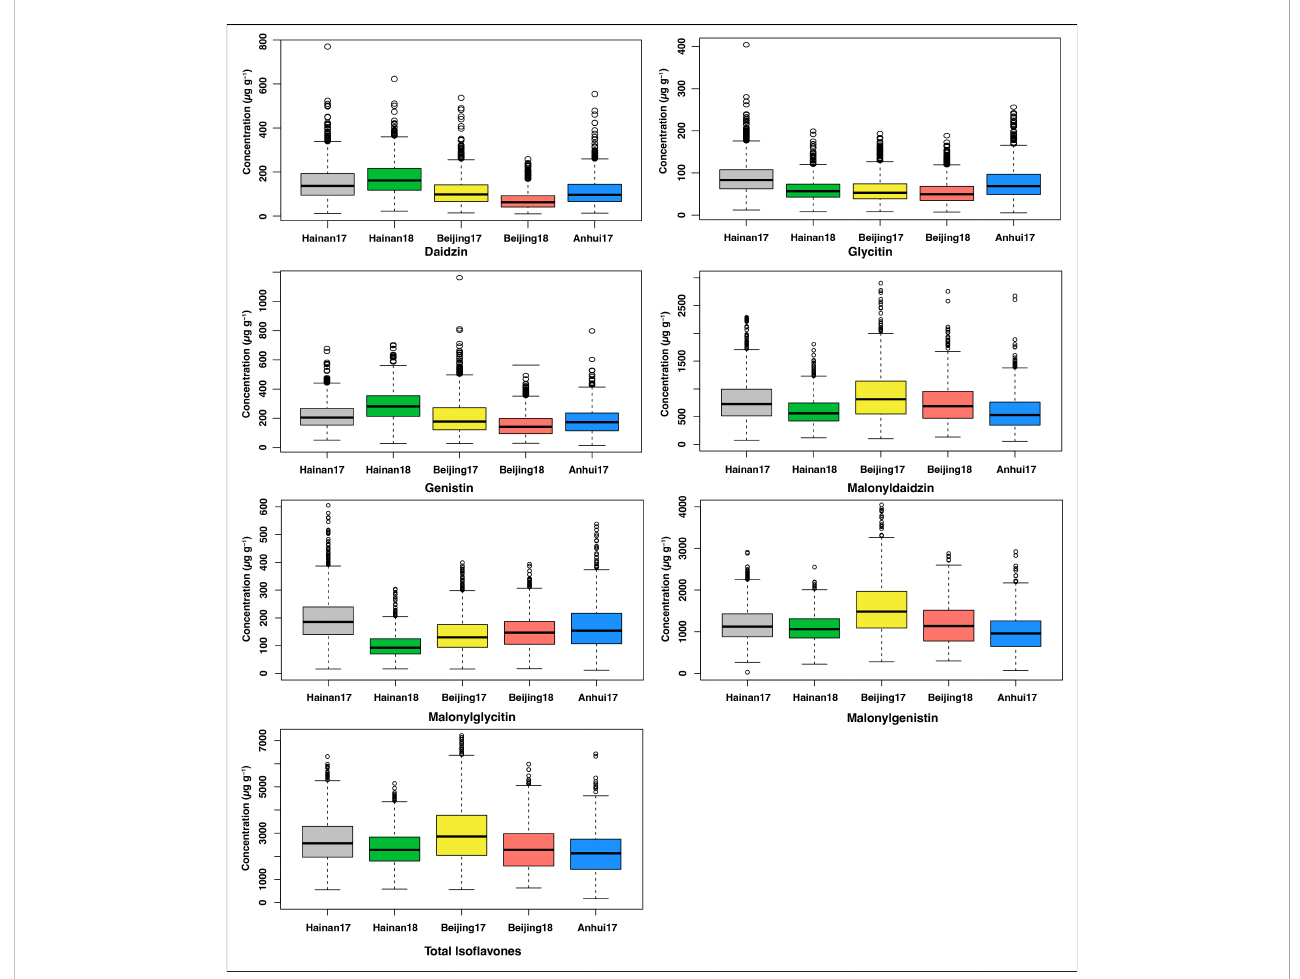
FIGURE 1 Individual and TIF content in fi ve environments (Hainan 2017 Hainan 2018, Beijing 2017, Beijing 2018, and Anhui